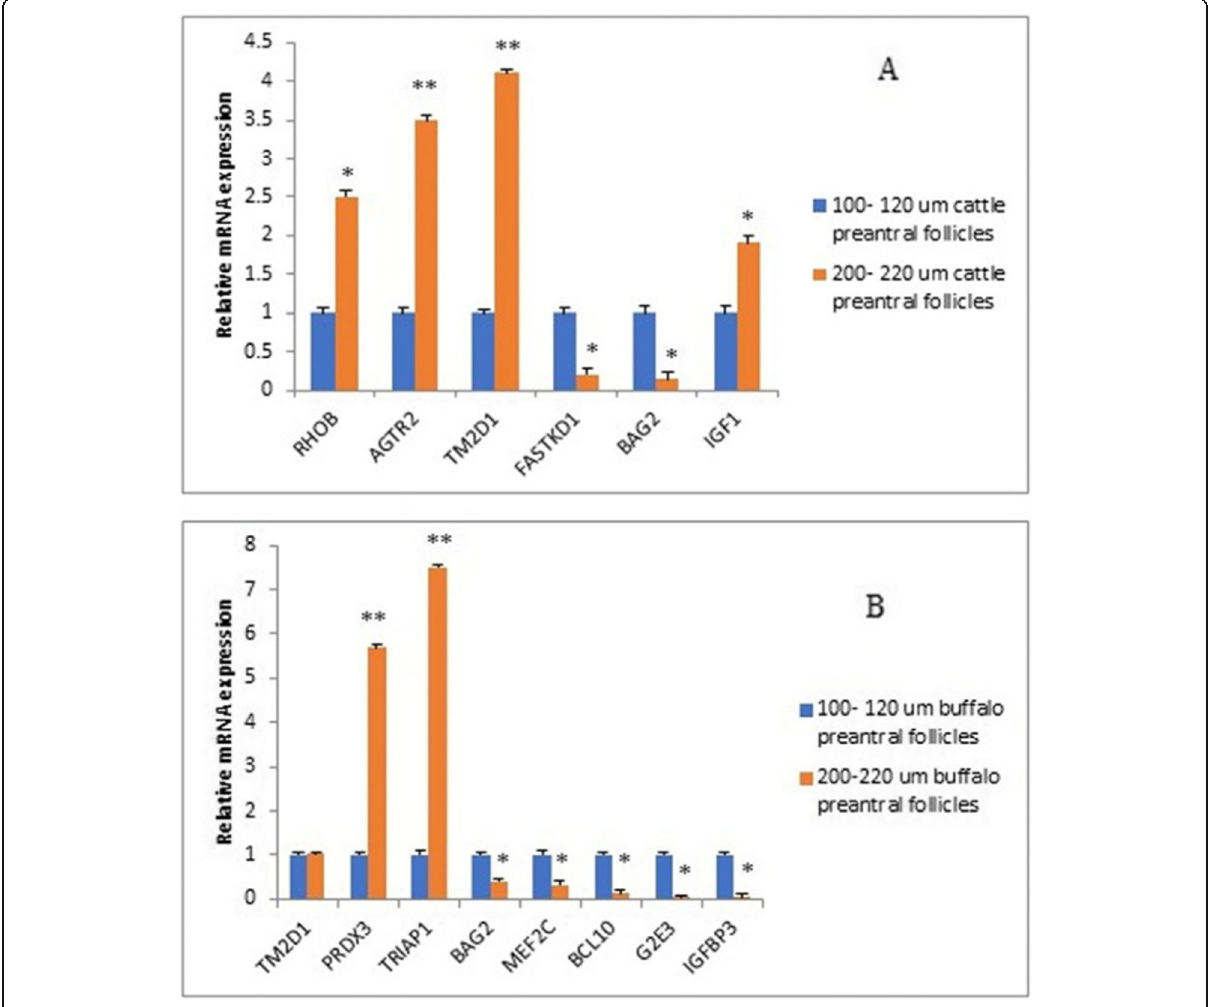
Fig. 2 The expression values of apoptotic genes in preantral follicles for large and small size in both buffalo and